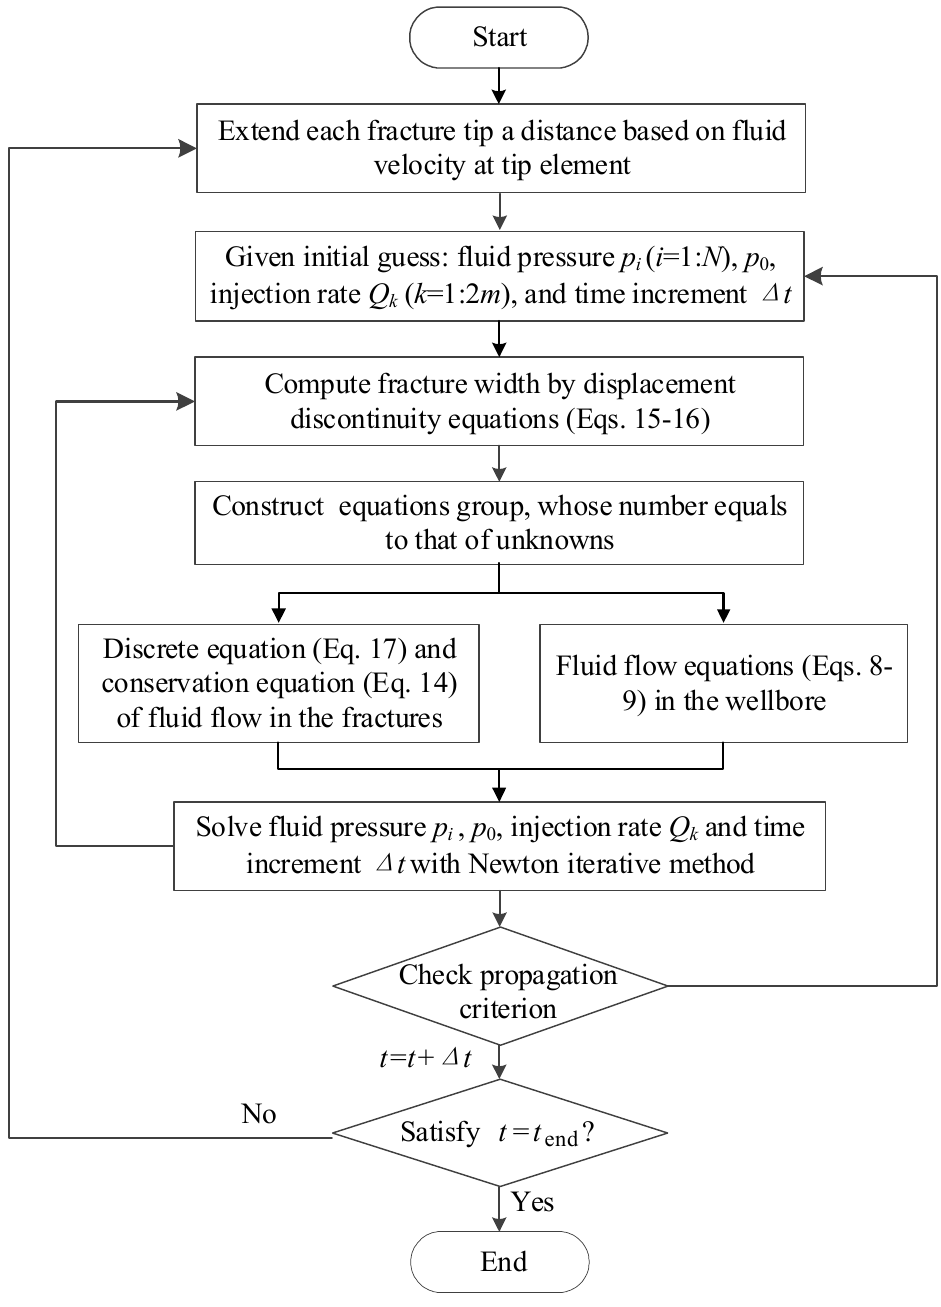
Figure 1. Flowchart of iteration scheme for fracture propagation model.